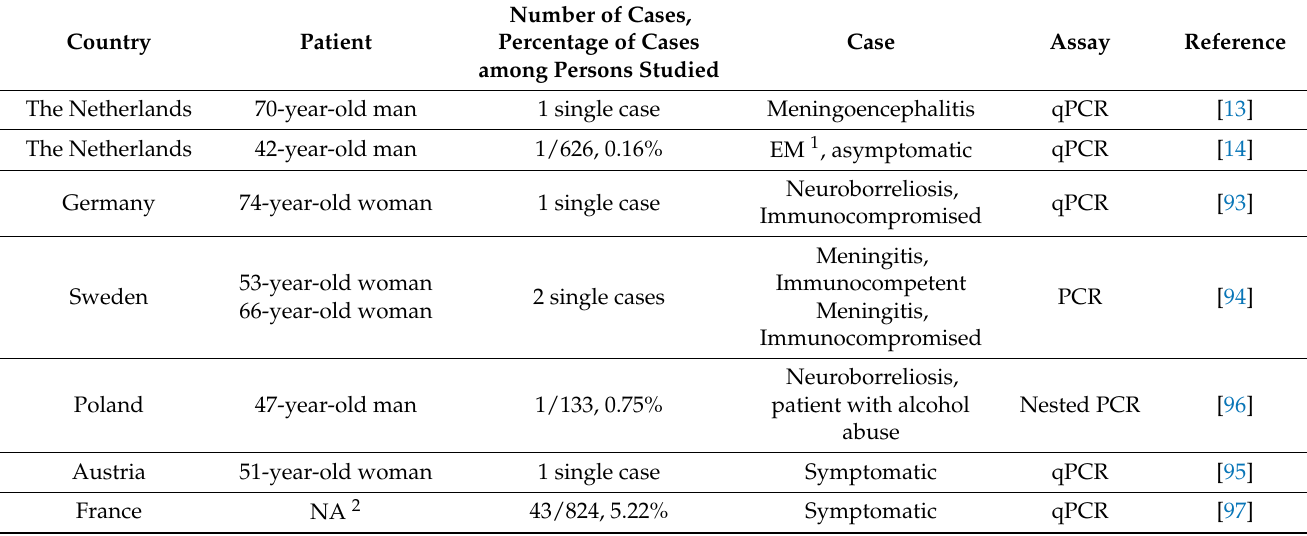
Table 2. Borrelia miyamotoi disease (BMD) DNA-positive cases in